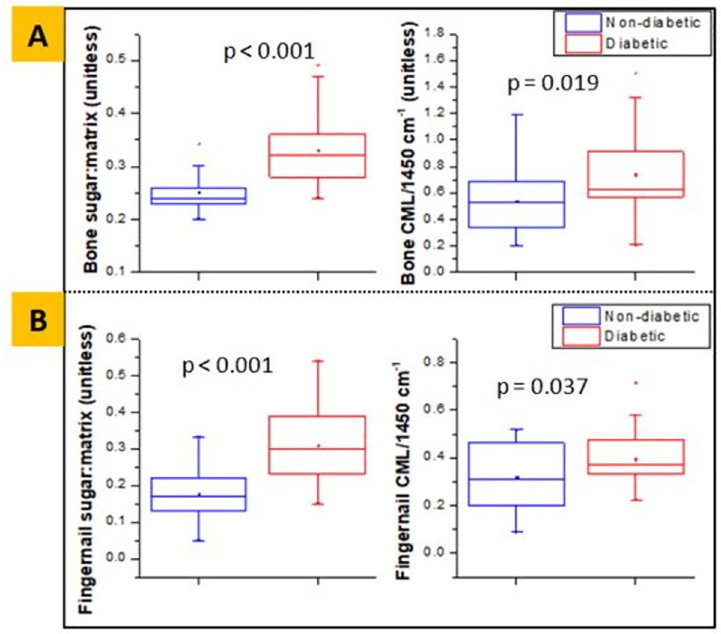
Fig 3. Sugar-to-matrix ratio and normalized CML content obtained from FTIR, showing higher mean values in diabetic group for both bone (A) and fingernail (B) respectively.